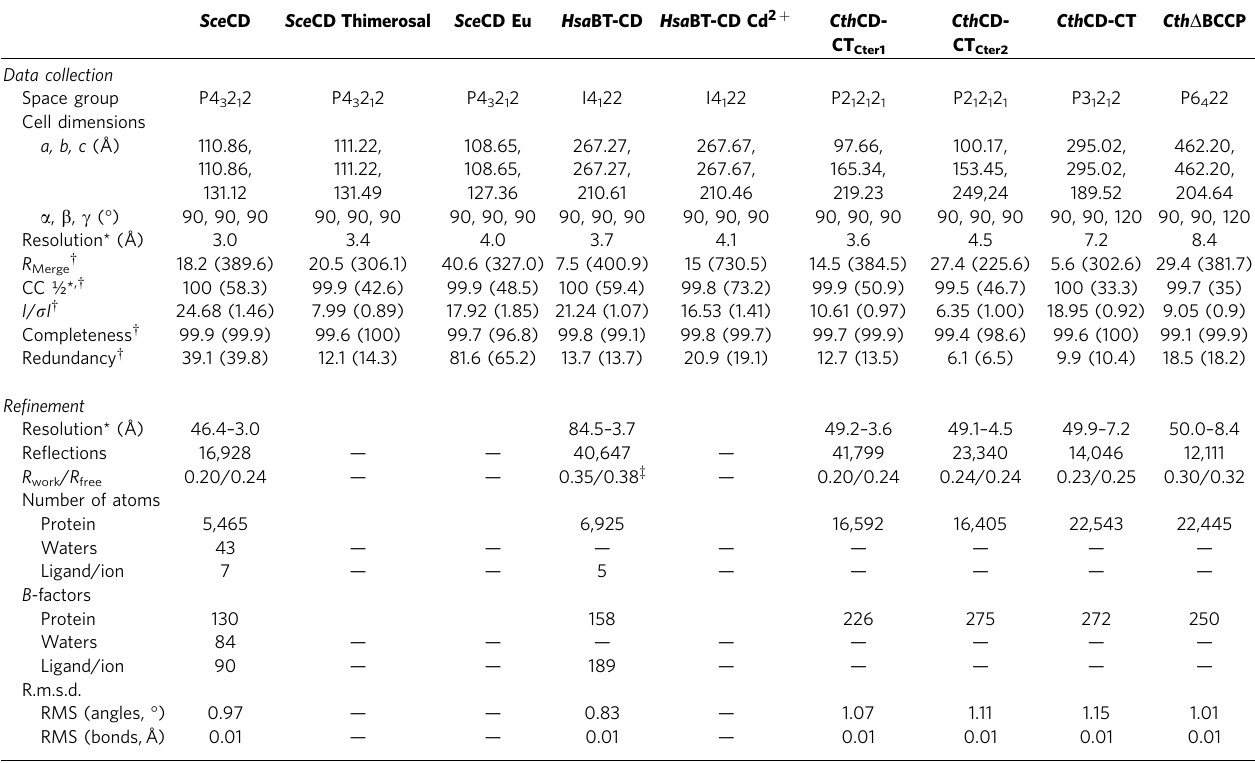
Table 1 | Crystallographic data collection and refinement statistics. Sce CD Sce CD Thimerosal Sce CD